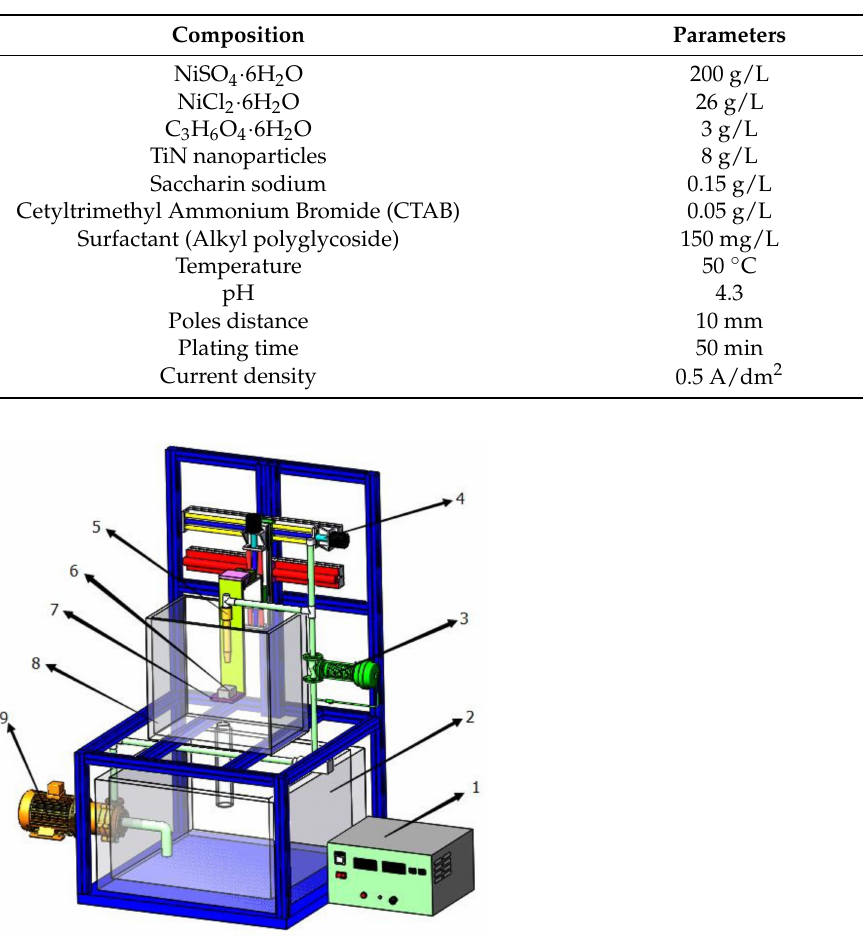
Table 1. Composition and parameters for prefabricating Ni–TiN coatings.